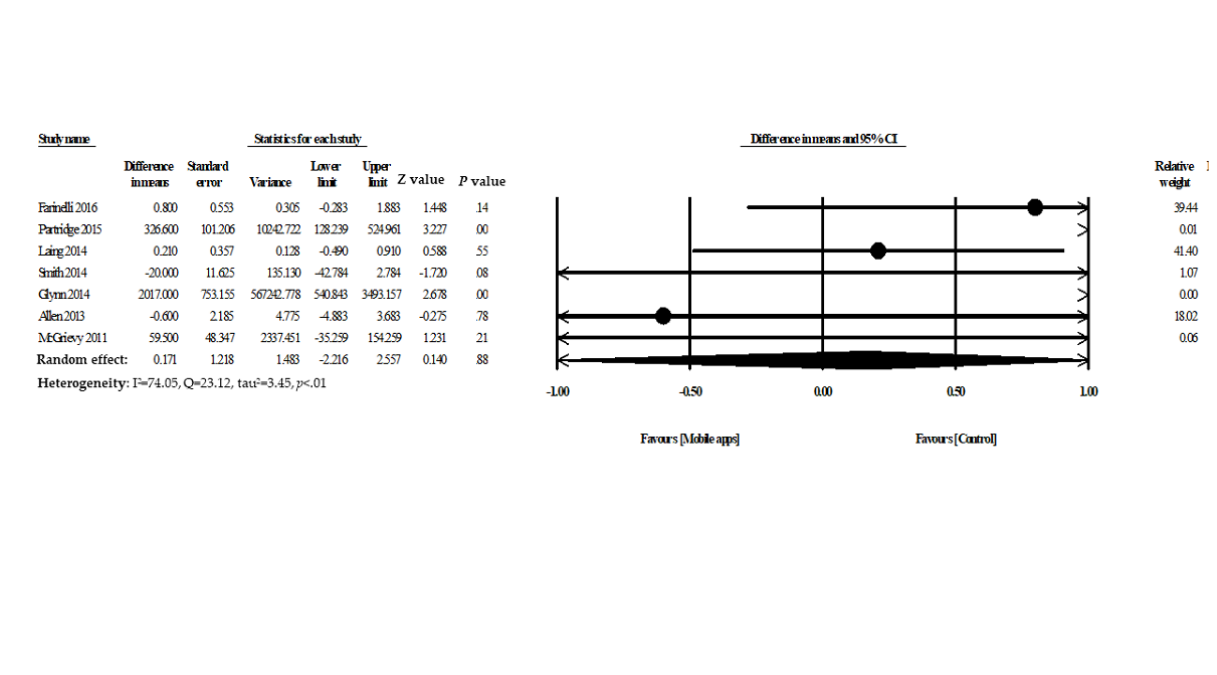
Figure 5. Forest plot of mobile phone apps for increased physical activity.